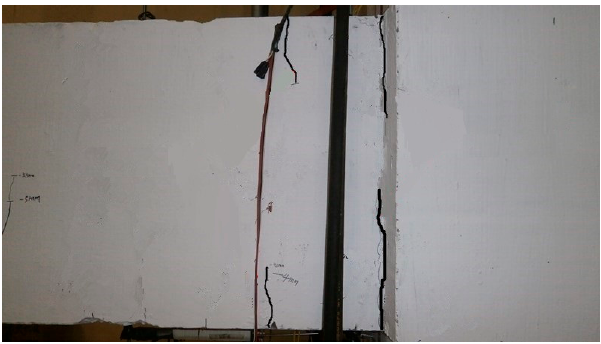
Figure 7. The initial cracking of the cast-in-place beam.